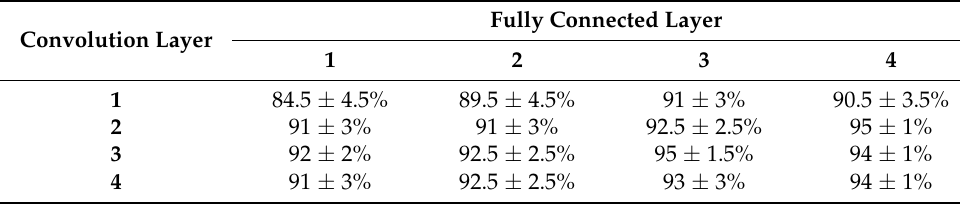
Table 3. Accuracy according to network architecture.